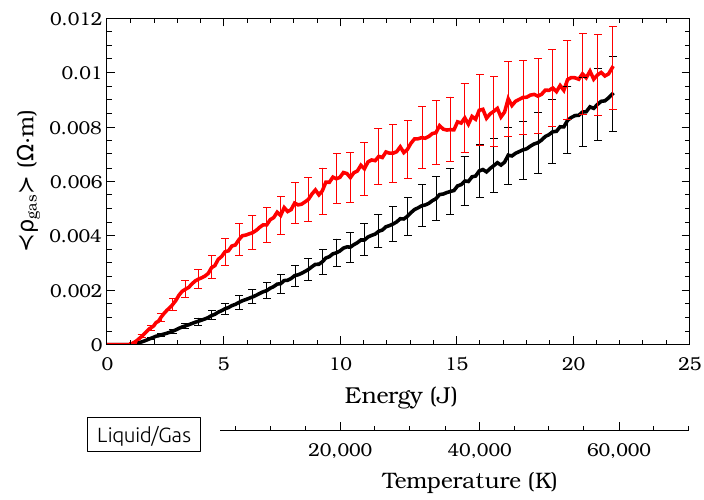
Figure 3. Mean copper gas resistivity experimental limits ( upper, lower) as a function of the absorbed energy for all measured voltages. Errors bars represent the statistical error among all cases. The lower scale indicates a mean gas temperature of a copper gas with a heat content equal to the measured electrical energy absorbed by the